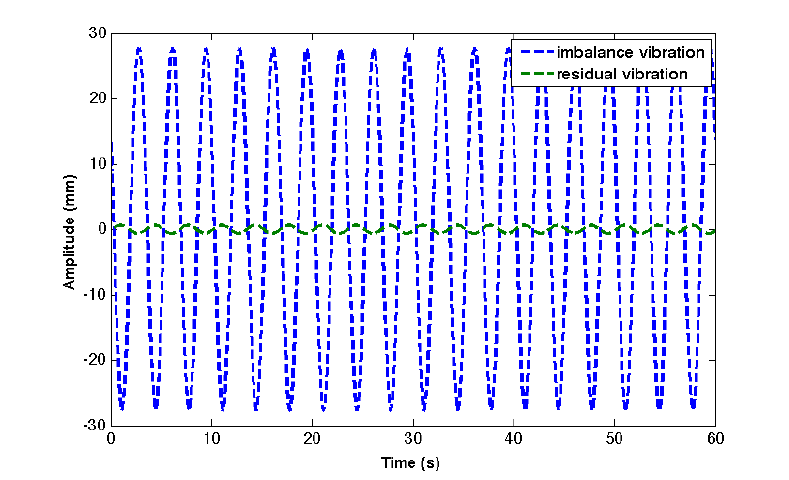
Figure 9 . Vibrations in z direction before and after balancing with the computed